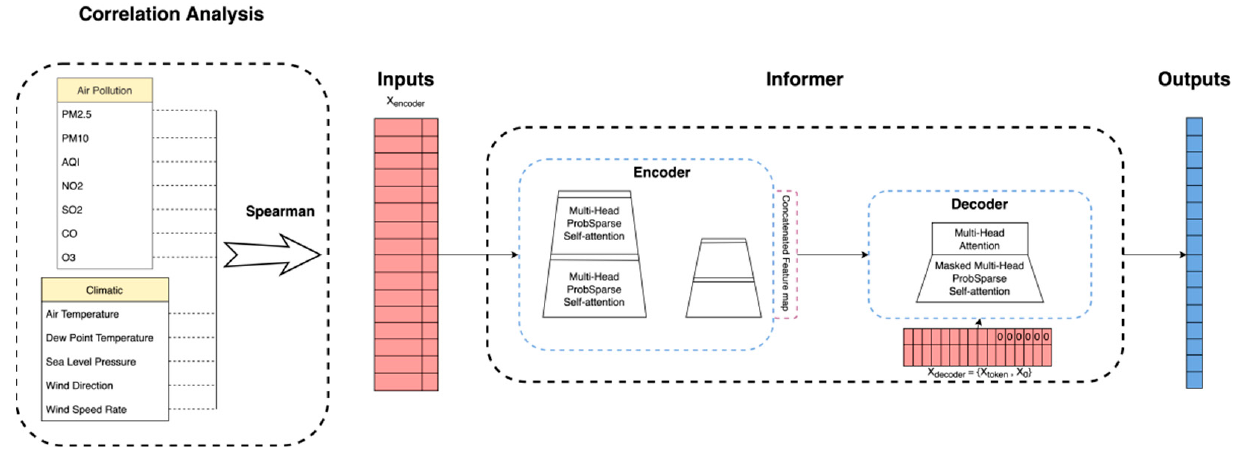
Figure 3. The structure of our predictor model.